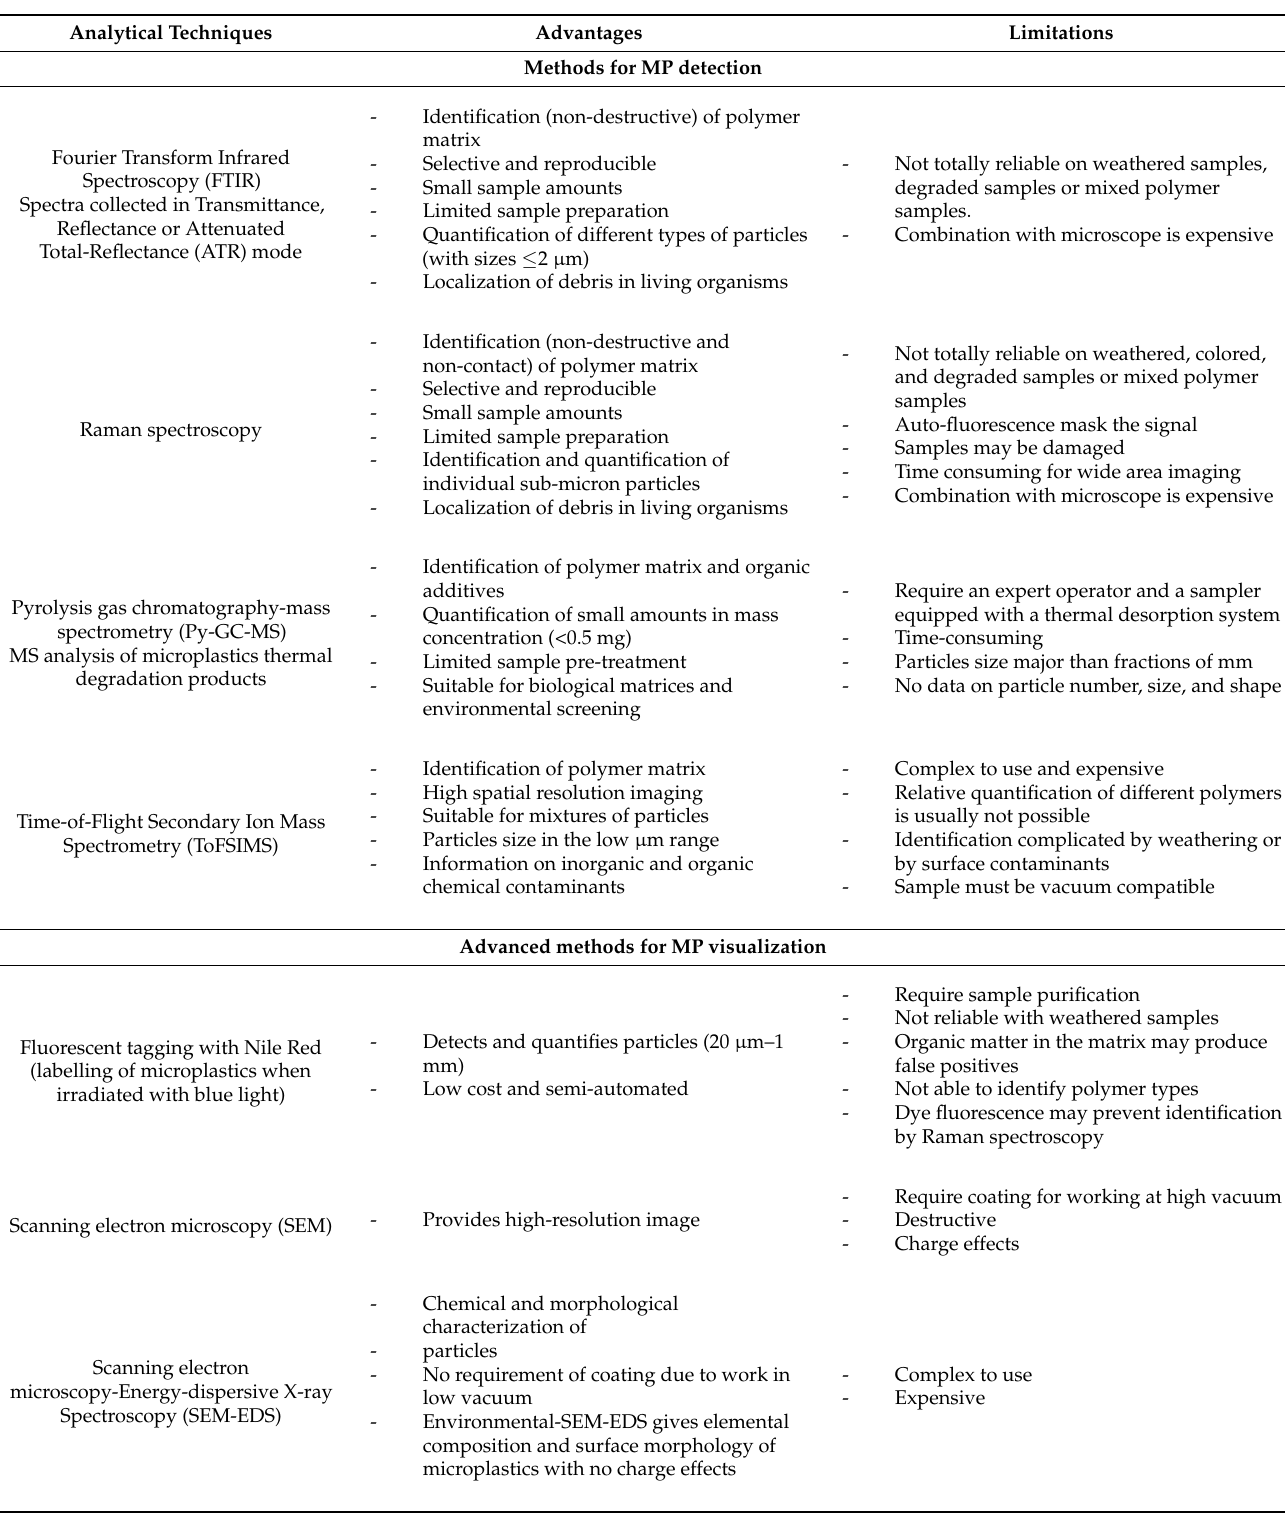
Table 3. Comparison of main analytical methods for MP detection and